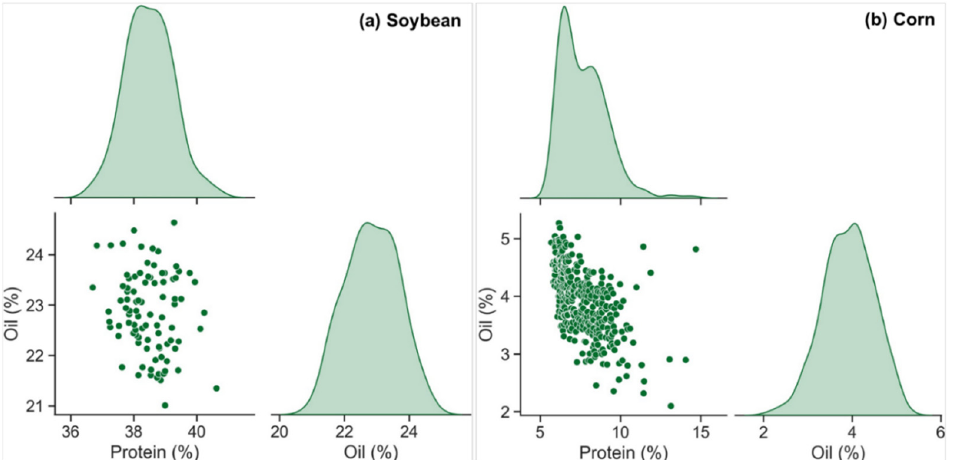
Figure 2. Scatter plots of protein against oil and the distribution pattern of protein and oil composi- tion data: ( a ) soybean protein and oil composition data and ( b ) corn protein and oil composition data.